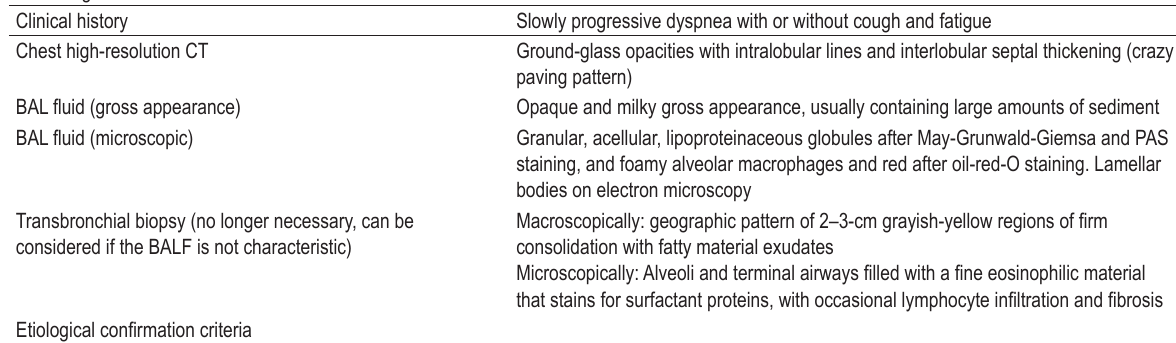
FIGURE 4. Left: Normal saline, right: Bronchoalveolar lavage fluid with opaque and milky TABLE 1. Diagnostic criteria for pulmonary alveolar proteinosis (1,2,4,6,8). Main diagnostic criteria